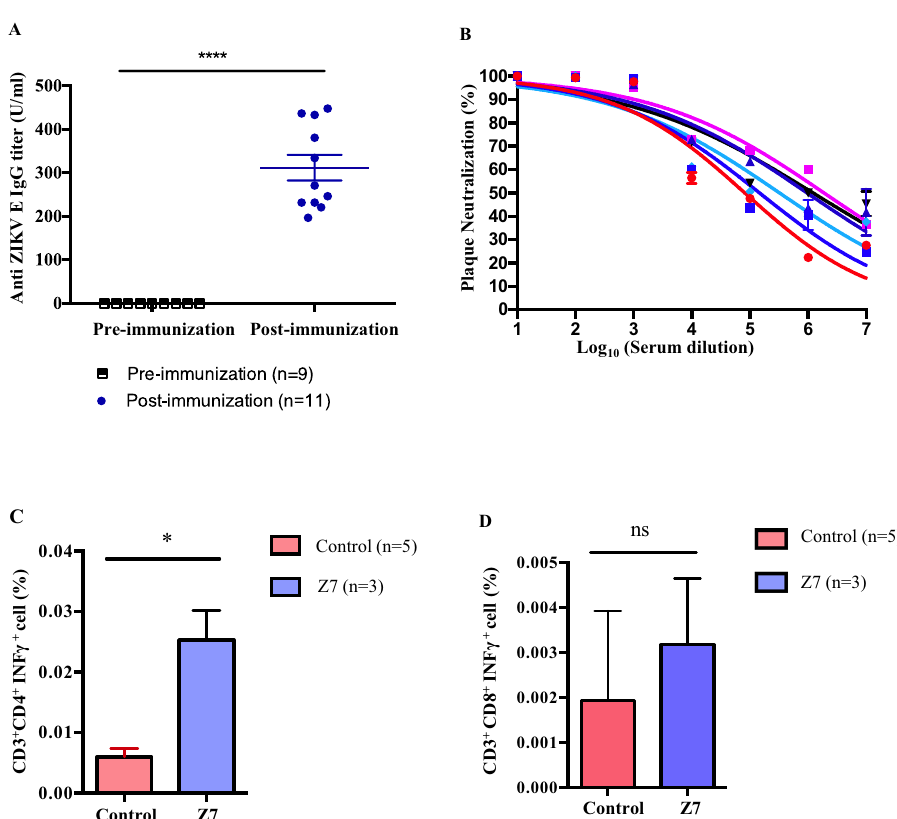
Fig. 5 Z7 induces robust IgG and T-cell responses in mice. A Anti-ZIKV E IgG response of Z7 immunization. Four-week-old Ifnar1 − / − mice were immunized with 1 × 10 5 FFU of Z7 (G10) via footpad. Anti-ZIKV E IgG was measured in the plasma samples from D0 (pre-immunization) and D24 (post-immunization) by ELISA. B PRNT. Six 4-week-old Ifnar1 − / − mice were immunized with 2 × 10 4 FFU of Z7 (G11) via footpad. On D24 p.i., plasma samples were collected. The ZIKV neutralizing capacity of the plasma from each mouse was determined by PRNT. C , D Cellular immune responses of Z7 immunization. Seven-week-old Ifnar1 − / − mice were immunized with 1 × 10 5 FFU of Z7 (G10) or PBS (control) via footpad. On D8 p.i., splenocytes were collected and re-stimulated with Z1 ex vivo for 24 h. The IFN- γ producing (C) CD4 + and ( D ) CD8 + T cells were measured by fl ow cytometry. Data were compared with a two-tailed Student ’ s t -test ( A ), Mann – Whitney U tests ( C , D ) and presented as mean ± s.e.m. with * p < 0.05, and **** p <